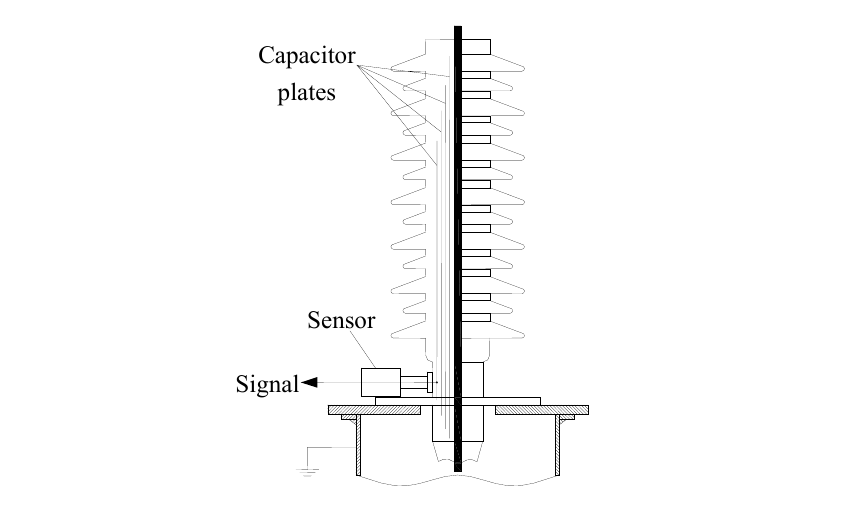
Figure 1. Installation diagram of transformer bushing top.